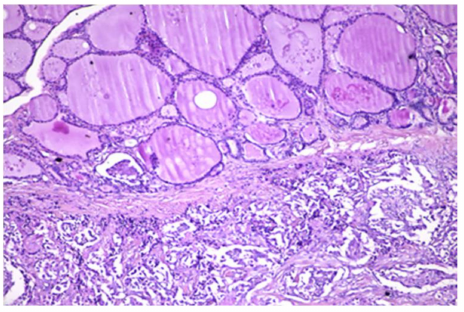
Figure 11. Thyroid papillary carcinoma. HE, 10 ×